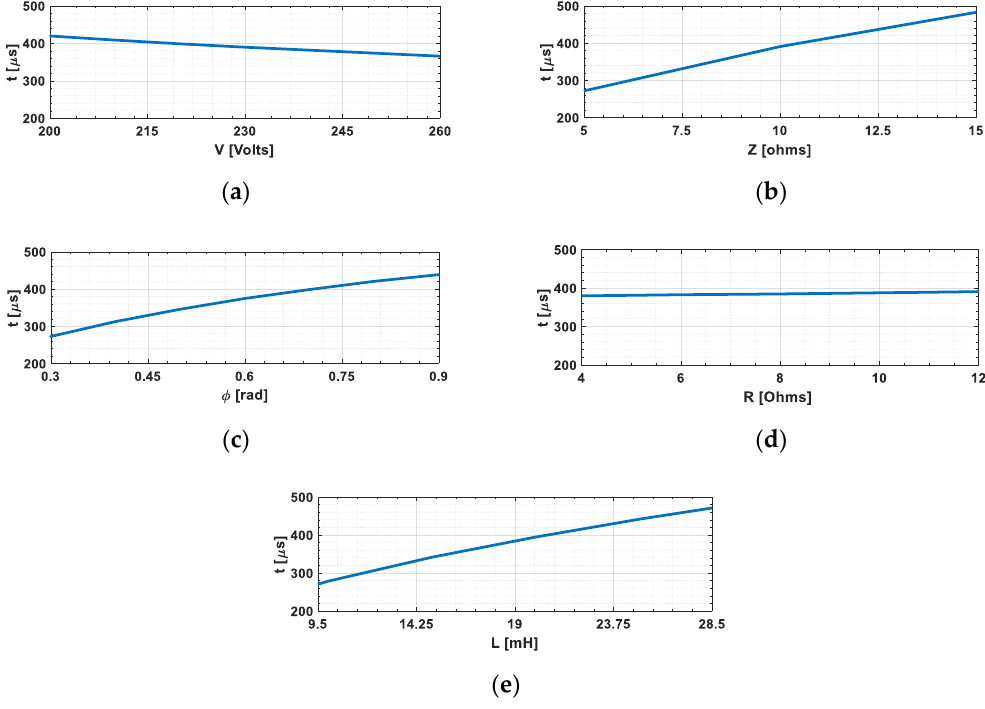
Figure 8. Minimum time duration in function of ( a ) main voltage V , ( b ) Z load, ( c ) ϕ load, ( d ) R load and ( e ) L load variation.